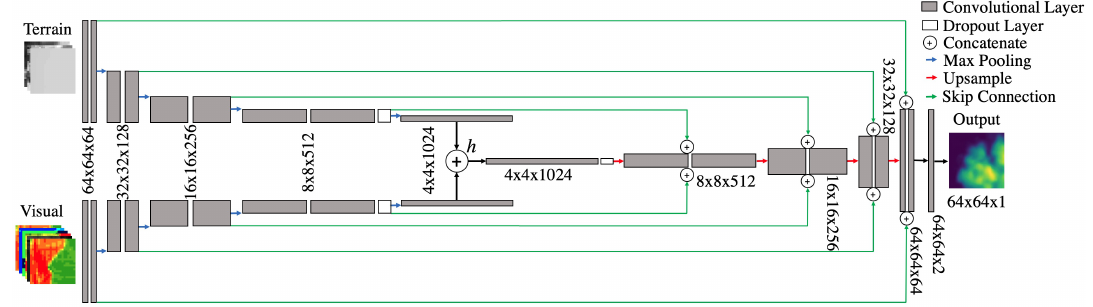
Figure 5. The Y-NET architecture receives terrain and visual data into two separate encoder branches, concatenates their latent representations, and passes through a single decoder. The output of Y-NET is a height estimation in R 1 for every pixel in a 64 × 64 pixel input tile location.